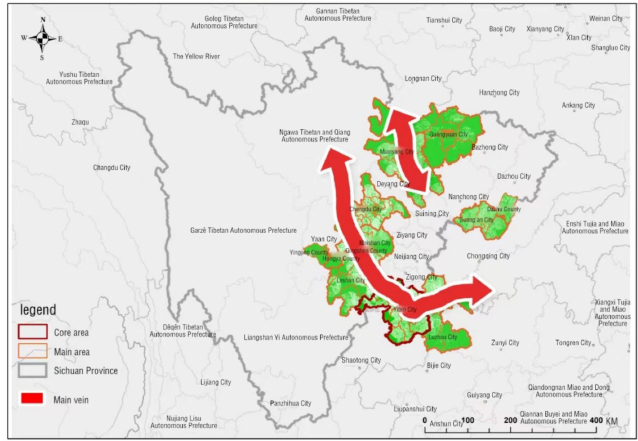
Figure 25. Distribution of main veins of research areas in Sichuan Province.